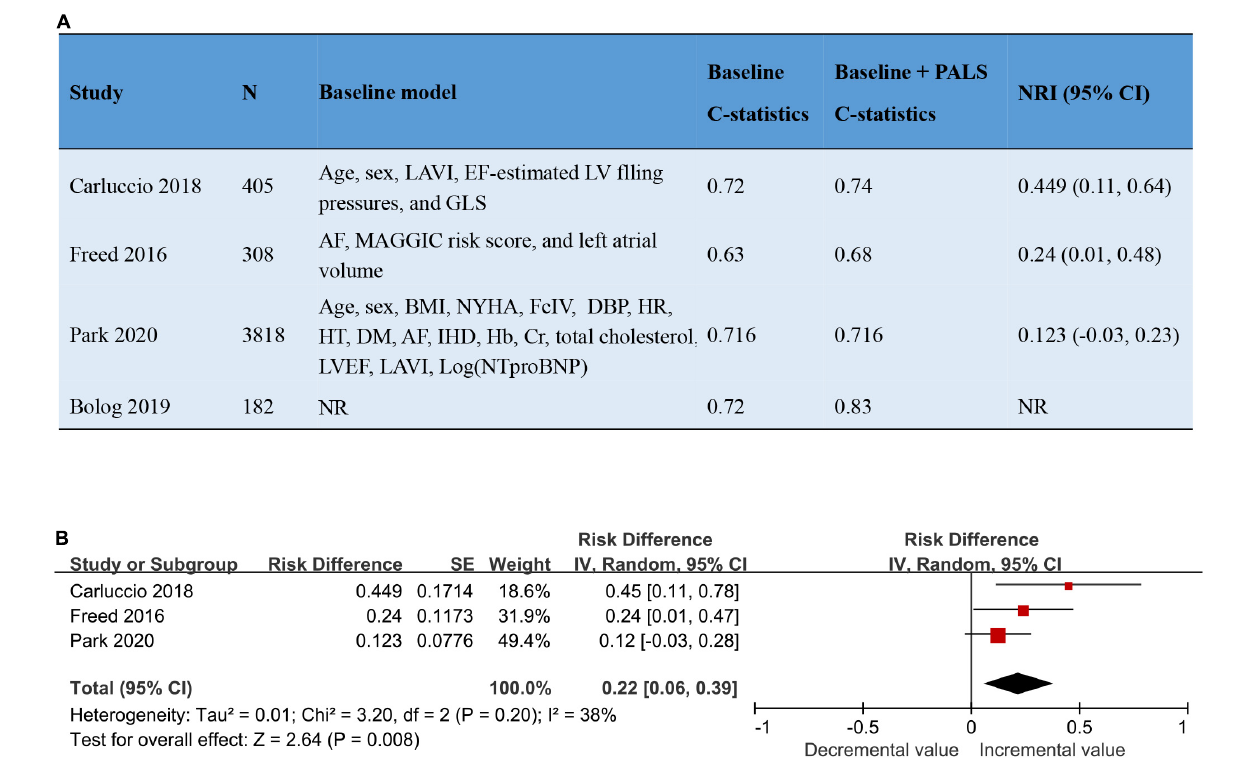
FIGURE 4 | The addition of PALS to baseline risk models led to a significant improvement in the predictive power of models. (A) Four studies reported the addition of PALS to baseline risk models. (B) The forest plot shows the pooled NRI of PALS for predicting adverse outcomes. AF, atrial fibrillation; BMI, body mass index; Cr, creatinine; DBP, diastolic blood pressure; DM, diabetes mellitus; Hb, hemoglobin level; GLS, global longitudinal strain; HR, heart rate; HT, hypertension; IHD, ischemic heart disease; LAVI, left atrial volume index; LVEF, left ventricular ejection fraction; NRI, net reclassification index; NR, not reported; NYHA, New York Heart